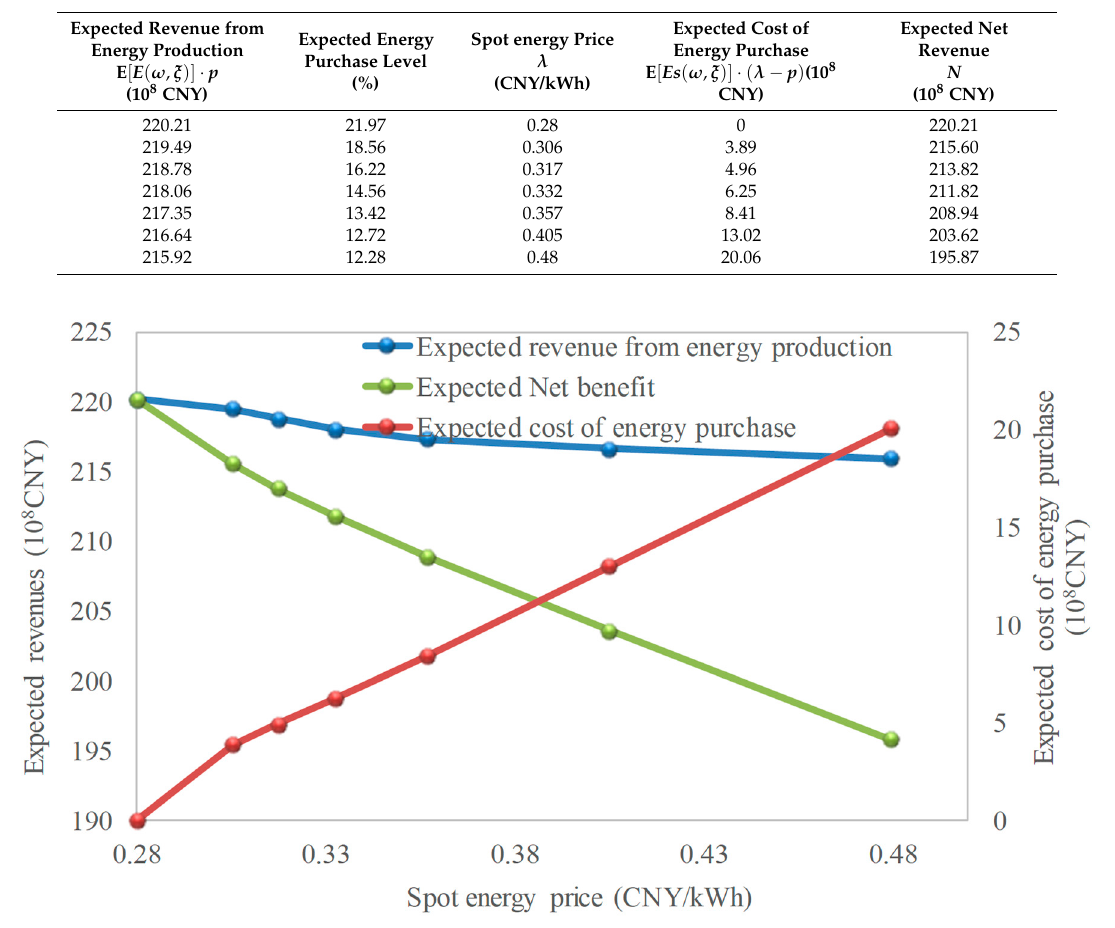
Figure 6. Revenue, cost, and net revenue under different spot energy prices.